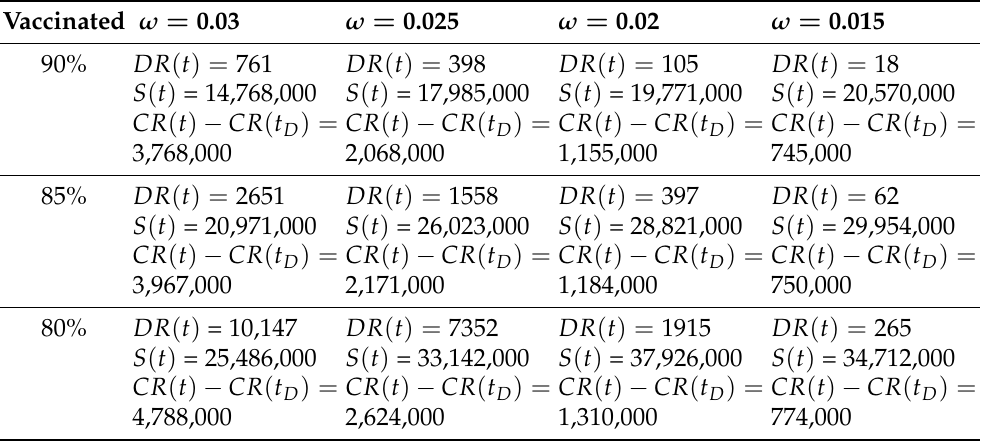
Table 1. Model simulations for daily reported cases DR ( t ) , susceptibles S ( t ) , and cumulative reported cases CR ( t ) − CR ( t D ) since the last date of data, where t = 1 January 2022 for fully vaccinated = 90%, 85%, 80% and social behaviour scaling factor ω = 0.03,0.025,0.02,0.015. Vaccinated ω =